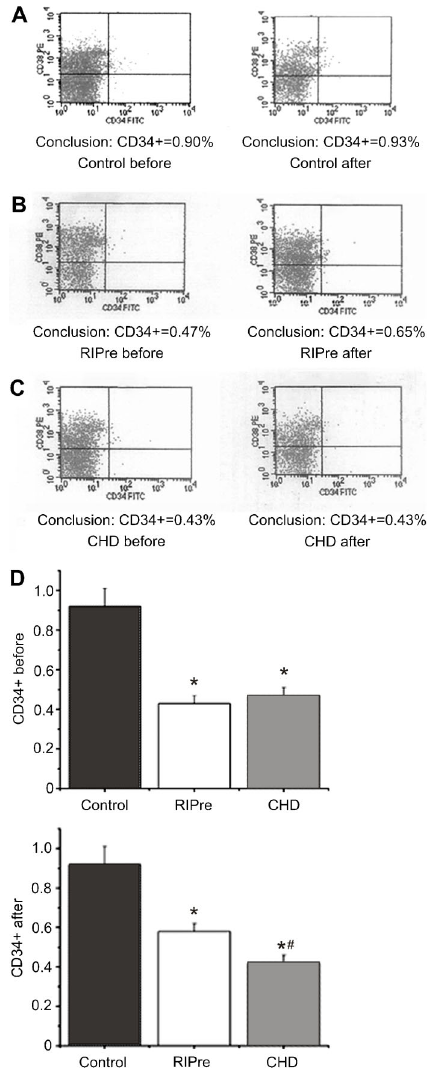
Figure 5. A , Representative flow cytometry measurements of CD34 + monocytes in blood before and after treatment in the A , control group; B , remote ischemic preconditioning (RIPre) group; and C , coronary heart disease (CHD) group. D , CD34 + monocytes in blood before and after treatment. Data are reported as means±SE. *P , 0.05 vs control group; # P , 0.05 vs RIPre group (Student-Newman-Keuls